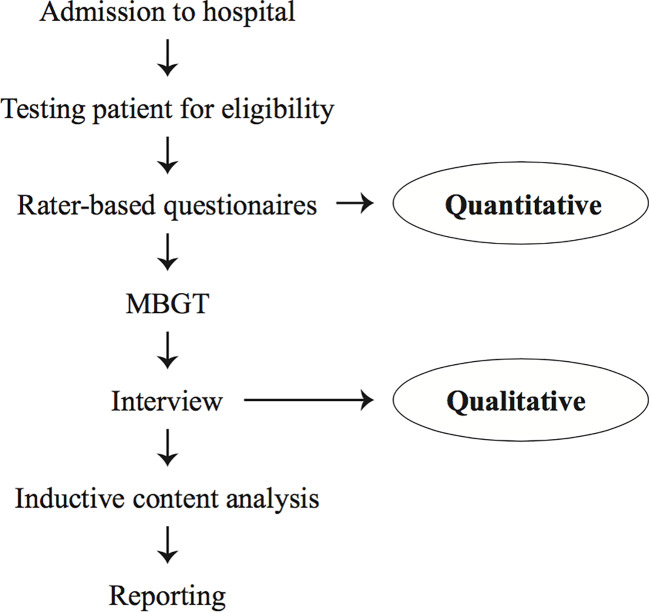
Study flow diagram.